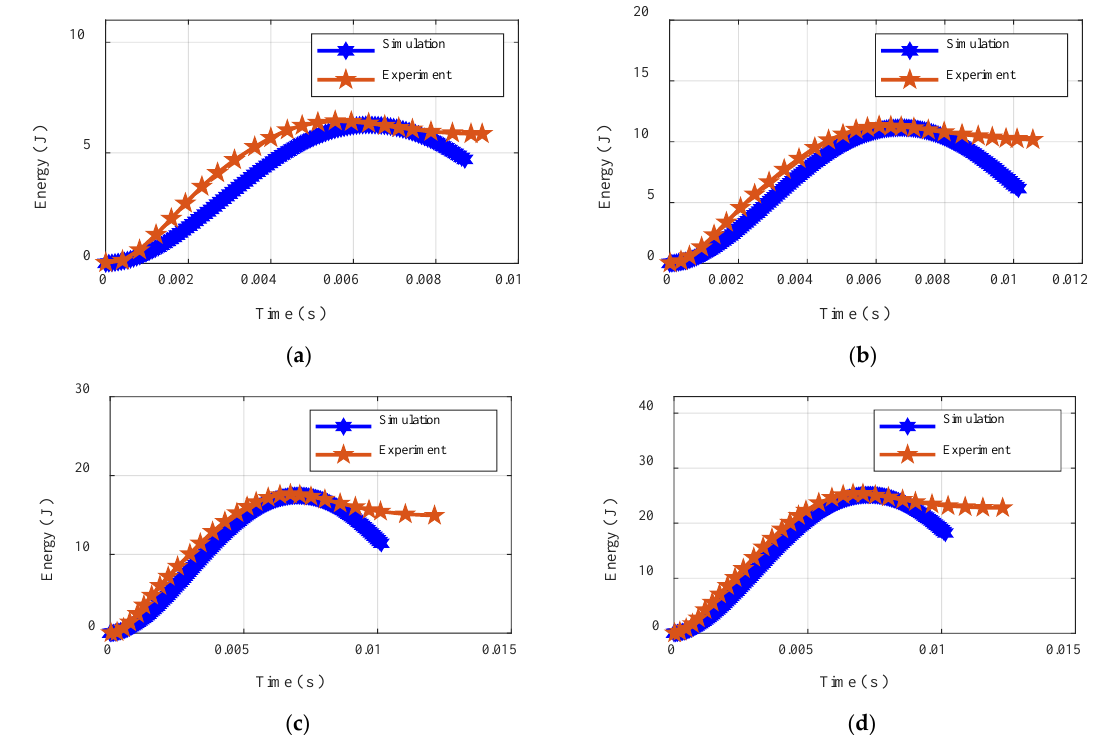
Figure 7. The energy variation versus time under increasing impact velocities: ( a ) 1.5 m/s, ( b ) 2 m/s, ( c ) 2.5 m/s, and ( d ) 3 m/s.